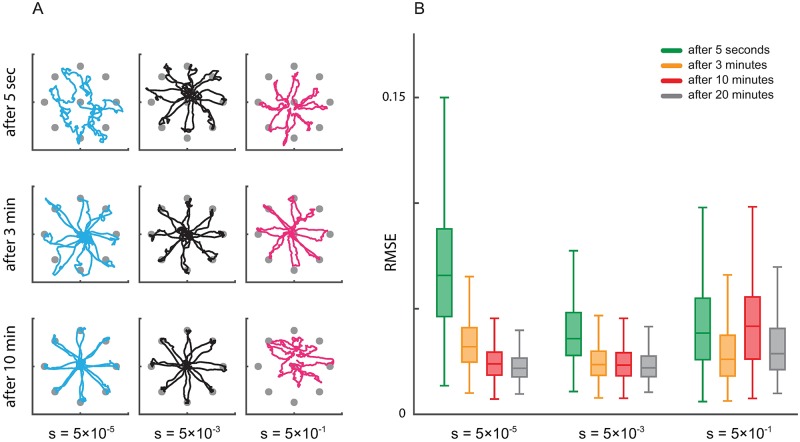
Learning rate calibration affects both the transient and the steady-state performance of closed-loop BMI decoders with continuous neural activity.(A) The evolution of the decoded trajectory as the adaptation time is increased under different learning rates s. Note that the decoder is fixed after a given adaptation time is completed (as noted on each row). The fixed decoder is then used to generate the displayed trajectories. Each color corresponds to one learning rate. Decoding performance is unstable when the learning rate is large (s = 5 × 10−1) even at steady state; this means that depending on exactly when we stop the adaptation and fix the decoder, performance widely oscillates due to the large steady-state model parameter error. (B) RMSE of the decoded trajectory under different learning rates for different adaptation times. RMSE is computed for a fixed decoder that was obtained by stopping the adaptation at various times (different colors). RMSE converges faster as the learning rate is increased (s = 5 × 10−5 to 5 × 10−3, for example). However, if the learning rate is selected too large (s = 5 × 10−1), RMSE oscillates depending on when adaptation is stopped, without converging to a stable number. These results show that appropriately calibrating the learning rate is important not only for encoding model estimation but also for a desired trade-off between convergence time and steady-state RMSE in decoding.